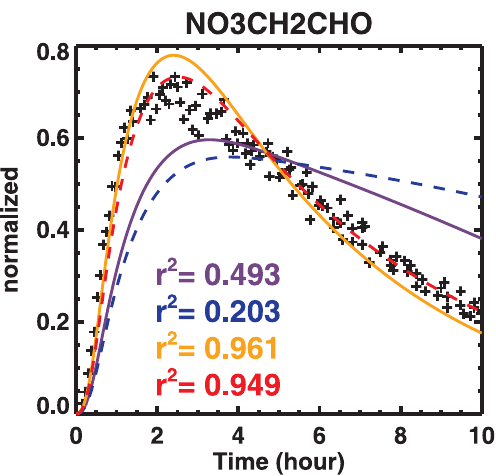
Fig. 5. Calculated mixing ratios of ethanal nitrate in the experi- ment of Paulot et al. (2009). The reported measurements are shown as black crosses. The model runs differ in the OH-reaction and pho- tolysis rates. The OH-reaction rates are obtained either from the MCMv3.2 (full lines) or from Neeb (2000) (dashed lines). Indigo and blue curves: MCM photolysis; orange and red: fast photolysis as described in this